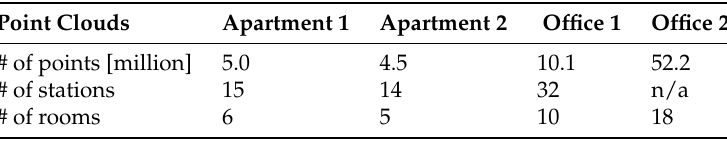
Table 1. The description and statistics of the input